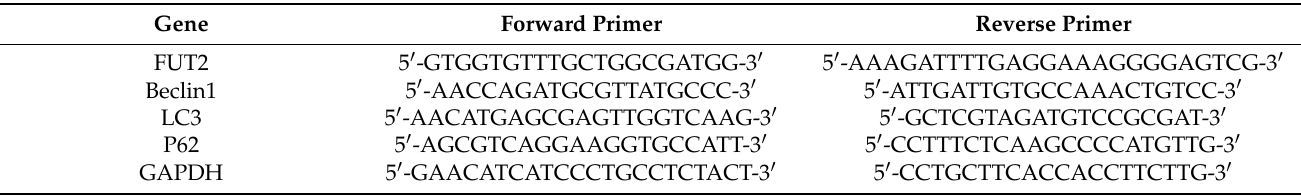
Table 1. Primer sequences used for gene expression